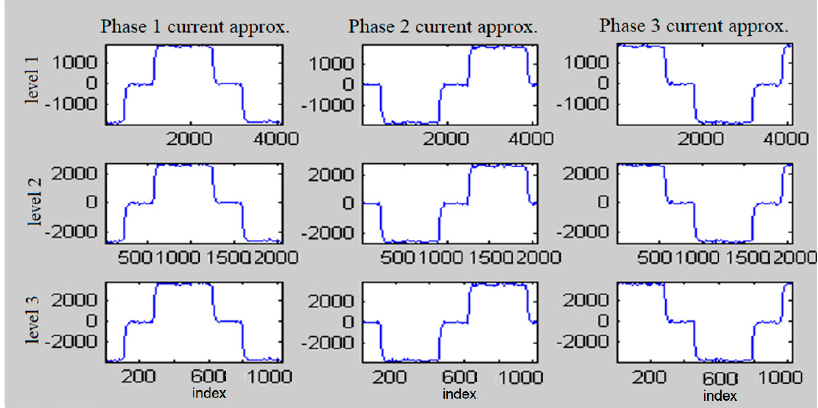
Figure 12. Vectors of approximations and details for voltages, level 10, first case study.